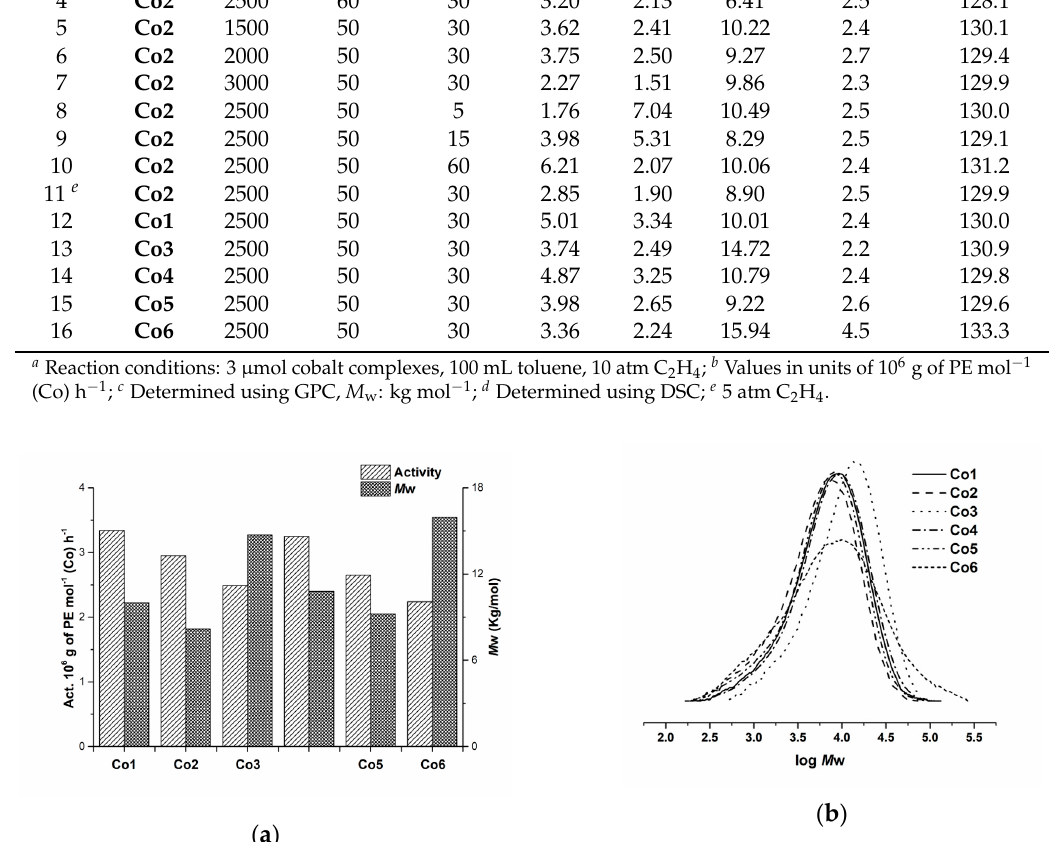
Table 3. Ethylene polymerization results using Co2 / MMAO a.